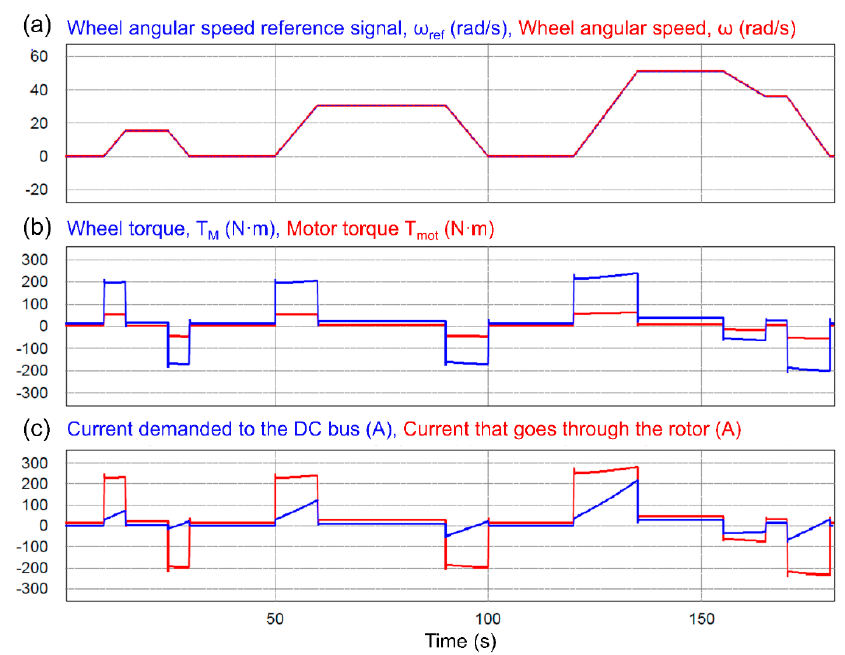
Figure 13. Example of the main Motor-vehicle waveforms obtained with an ECE-15 driving profile and the data included in Table 1 to Table 3.